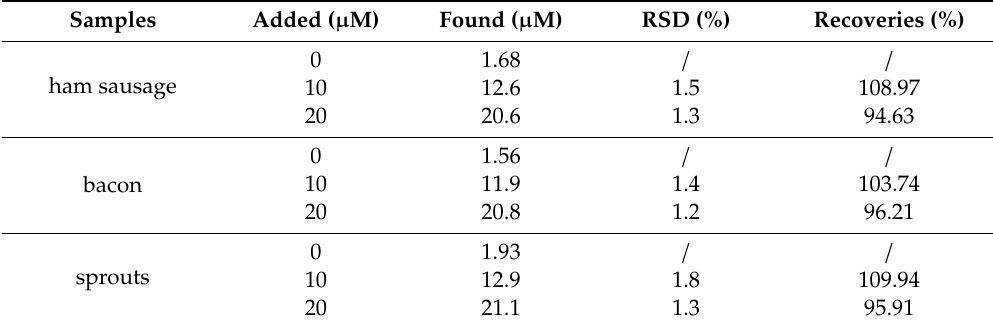
− in spiked ham sausage, bacon, and sprouts 2